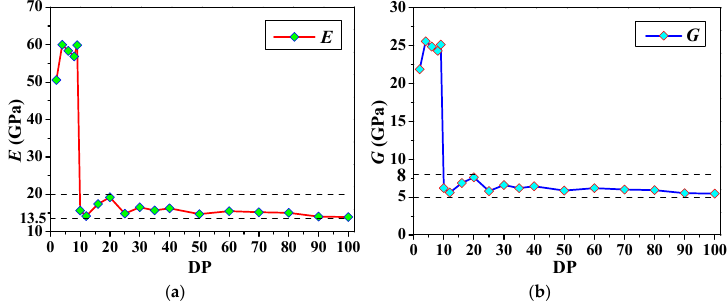
Figure 2. Changes of ( a ) the tensile modulus ( E ) and ( b ) the shear modulus ( G ) with DP simulated using the COMPASS force